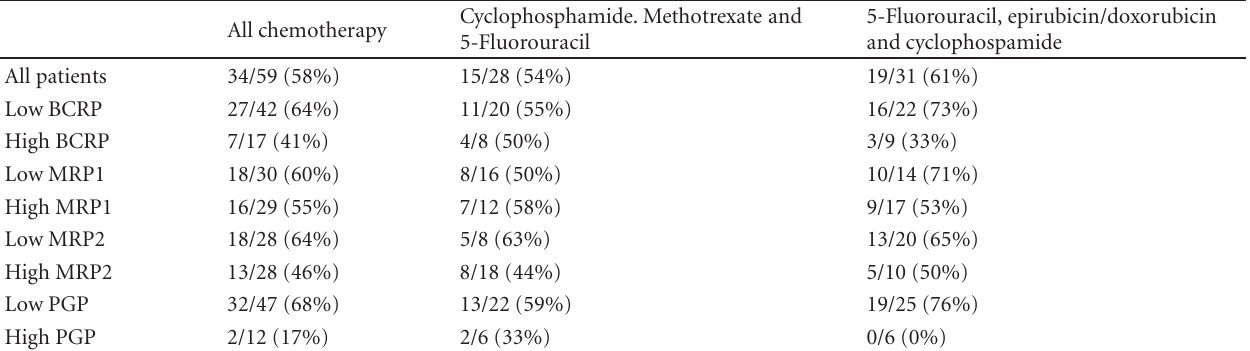
Table 3: E ff ect of ABC transporters on patient response rate to chemotherapy. All